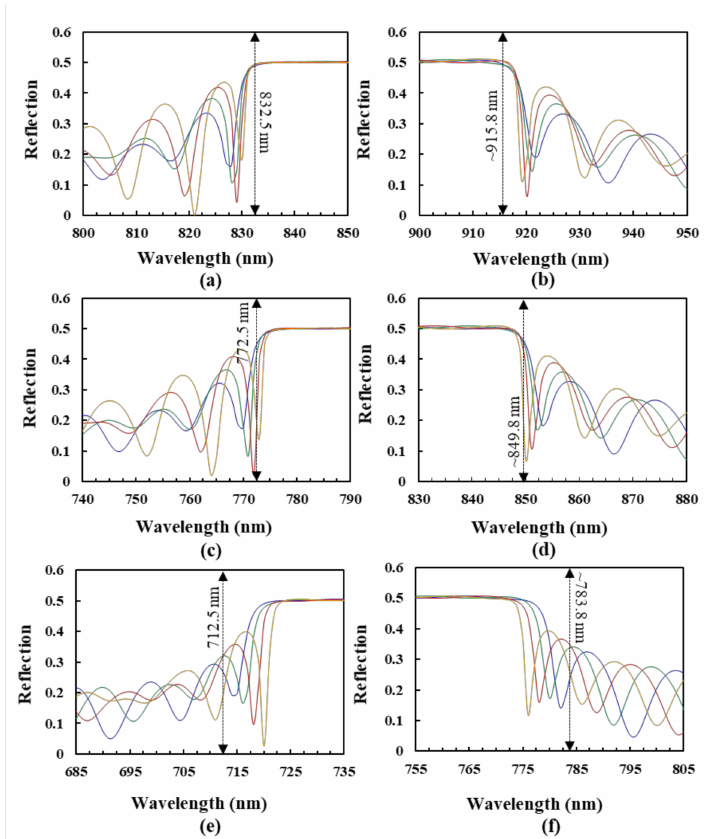
Figure 4. Simulation results of the reflection spectra of BLCPFs. ( a – f ) are the detailed reflection spectra in the black dashed circles plotted in Figure 3a–f,